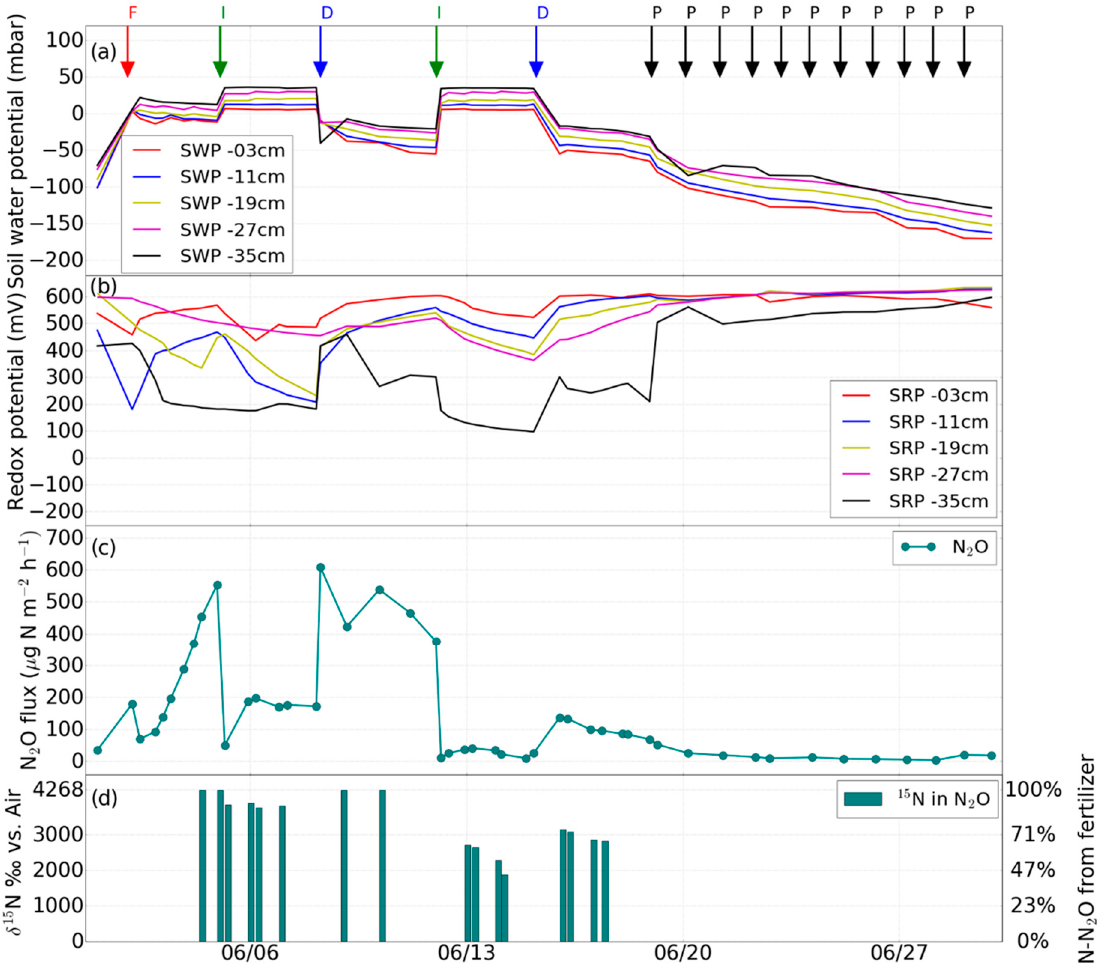
Figure 3. Experiment 2 (1st fertilization). Changes in ( a ) soil water potential (SWP), ( b ) soil redox potential (SRP), ( c ) N 2 O flux induced by irrigation (I), drainage (D), irrigation with fertilizer (F), desaturation of the soil with pump (P), ( d ) percentage of N 2 O from the added fertilizer.